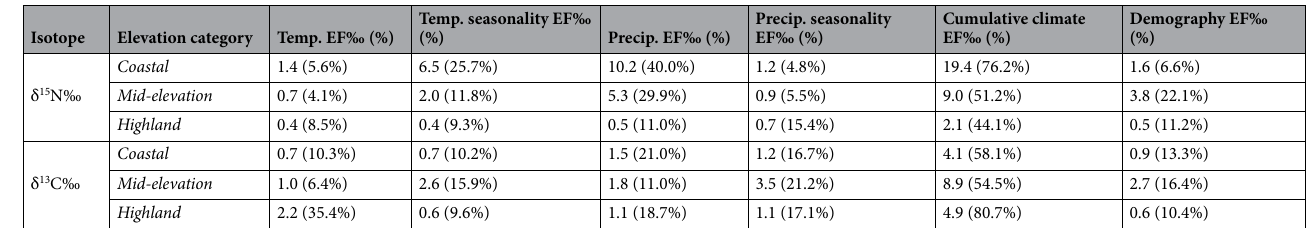
Table 1. Random Forest Model Effect Sizes with uncorrected KDEs. Model sum of squares effect sizes (amount of variation in δ 15 N‰ or δ 13 C‰ explained) for each variable within the elevation categories. These values are in per mil (‰). Percentages are the model sum of squares effect sizes as a percent of the total amount of variation. Effect sizes are directly comparable within each isotope, but not between them, given that there are different models for each stable isotope. Values here have been deducted by Friedman’s H -statistic to remove the proportion of the effects resulting from interaction between variables. Here demography is generated via uncorrected KDEs. Note: the effect sizes are calculated through iterated simulation employing representative subsets of each key predictor variable, as they do not include every possible combination the percentages will not sum to